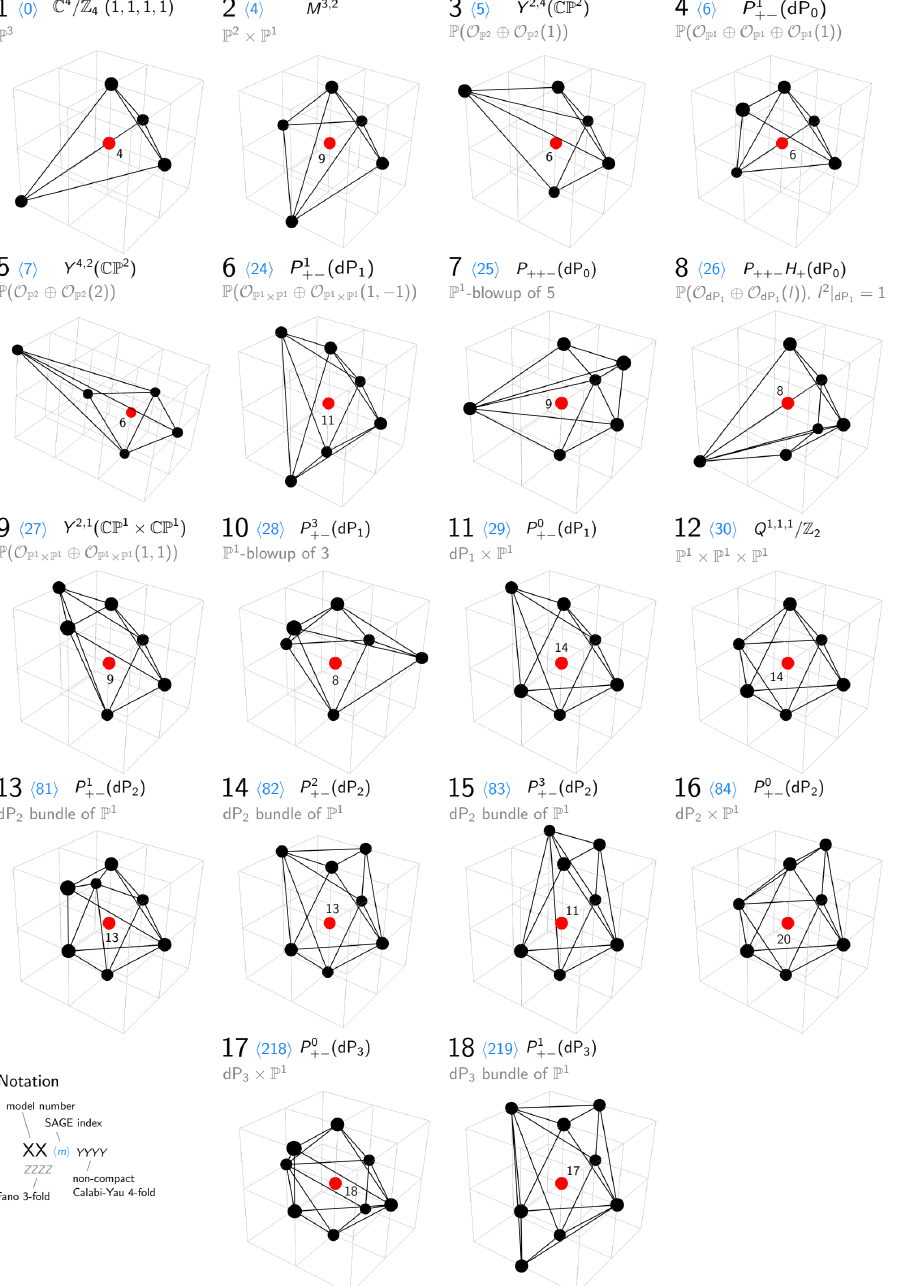
Figure 2 . The 18 regular reflexive polytopes in dimension 3 corresponding to toric non-compact Calabi-Yau 4-folds and corresponding smooth Fano